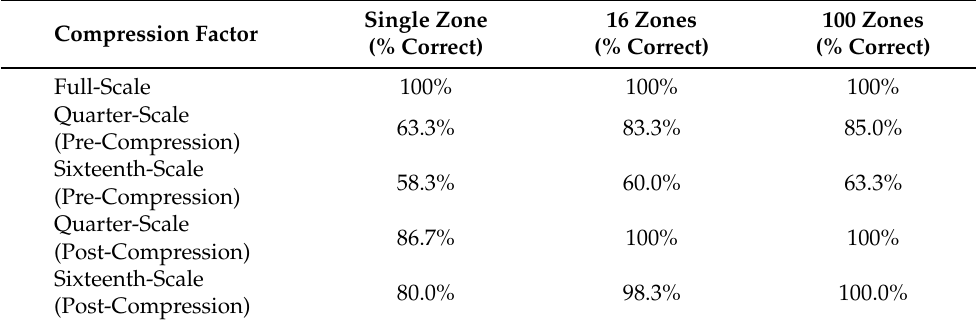
Table A2. Raspberry Pi Camera data-set identification performance.